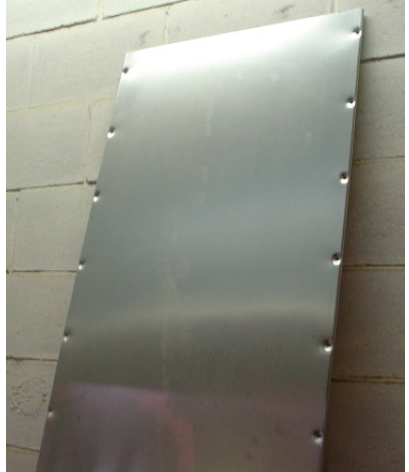
Figure 2. Sheet metal facia with plywood backing used in trailer inner liner wall panels.